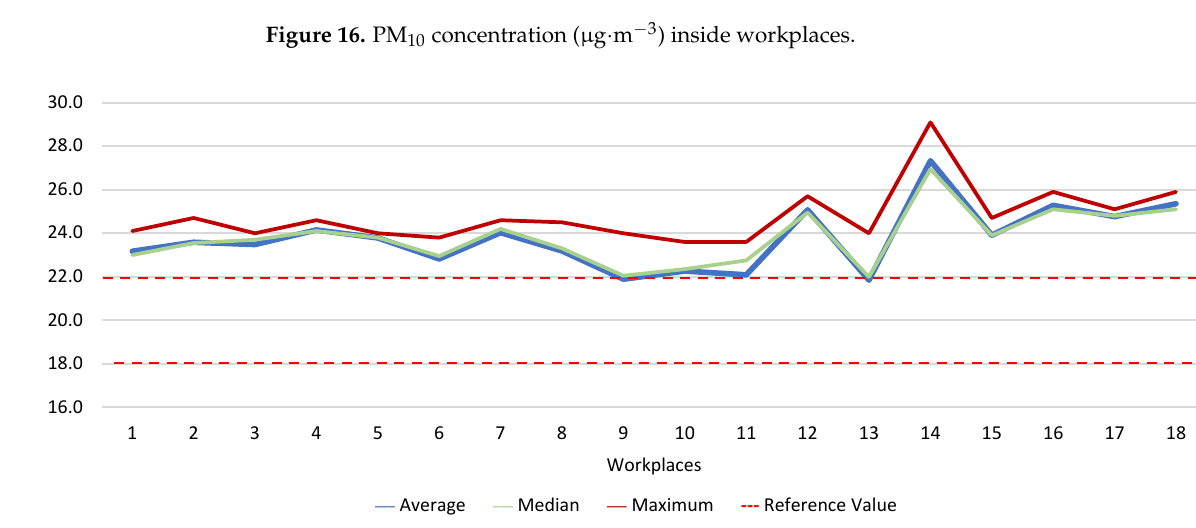
Figure 17. Temperature values (°C) inside workplaces.